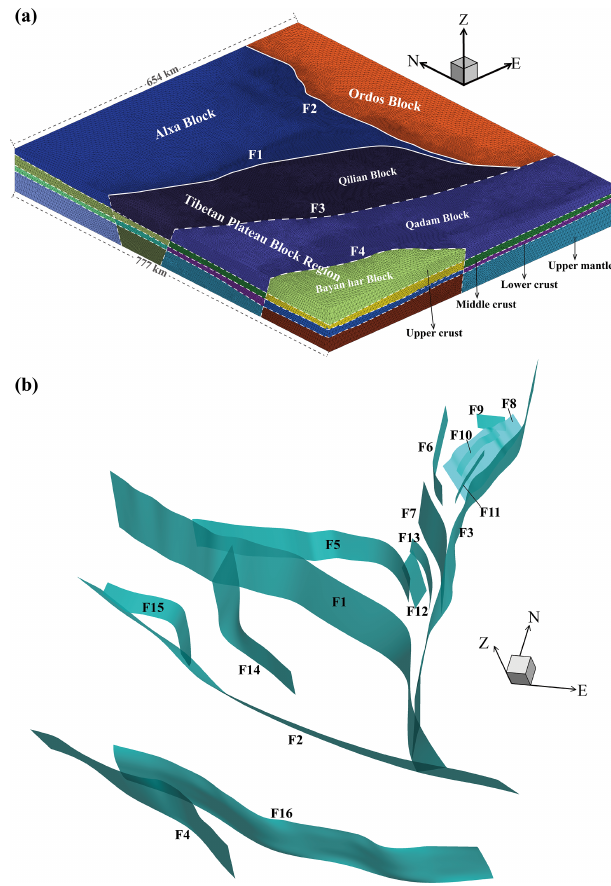
Figure 2. Model geometry and fault system. (a) Distribution of the rock types employed in the model. (b) Cyan surfaces indicate the faults implemented in the model as frictional contact surfaces. Fault names can be found in Fig.